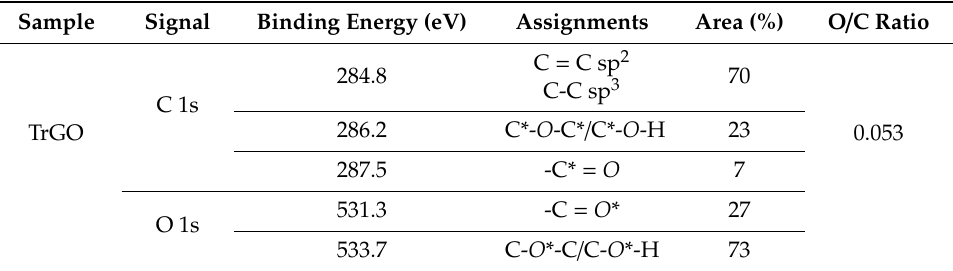
Figure 3. XPS of C 1s ( a ) and O 1s ( b ) photoelectric lines of TrGO. Table 1. O/C ratio, binding energy, assignment, and area peak of photoelectric lines in TrGO.